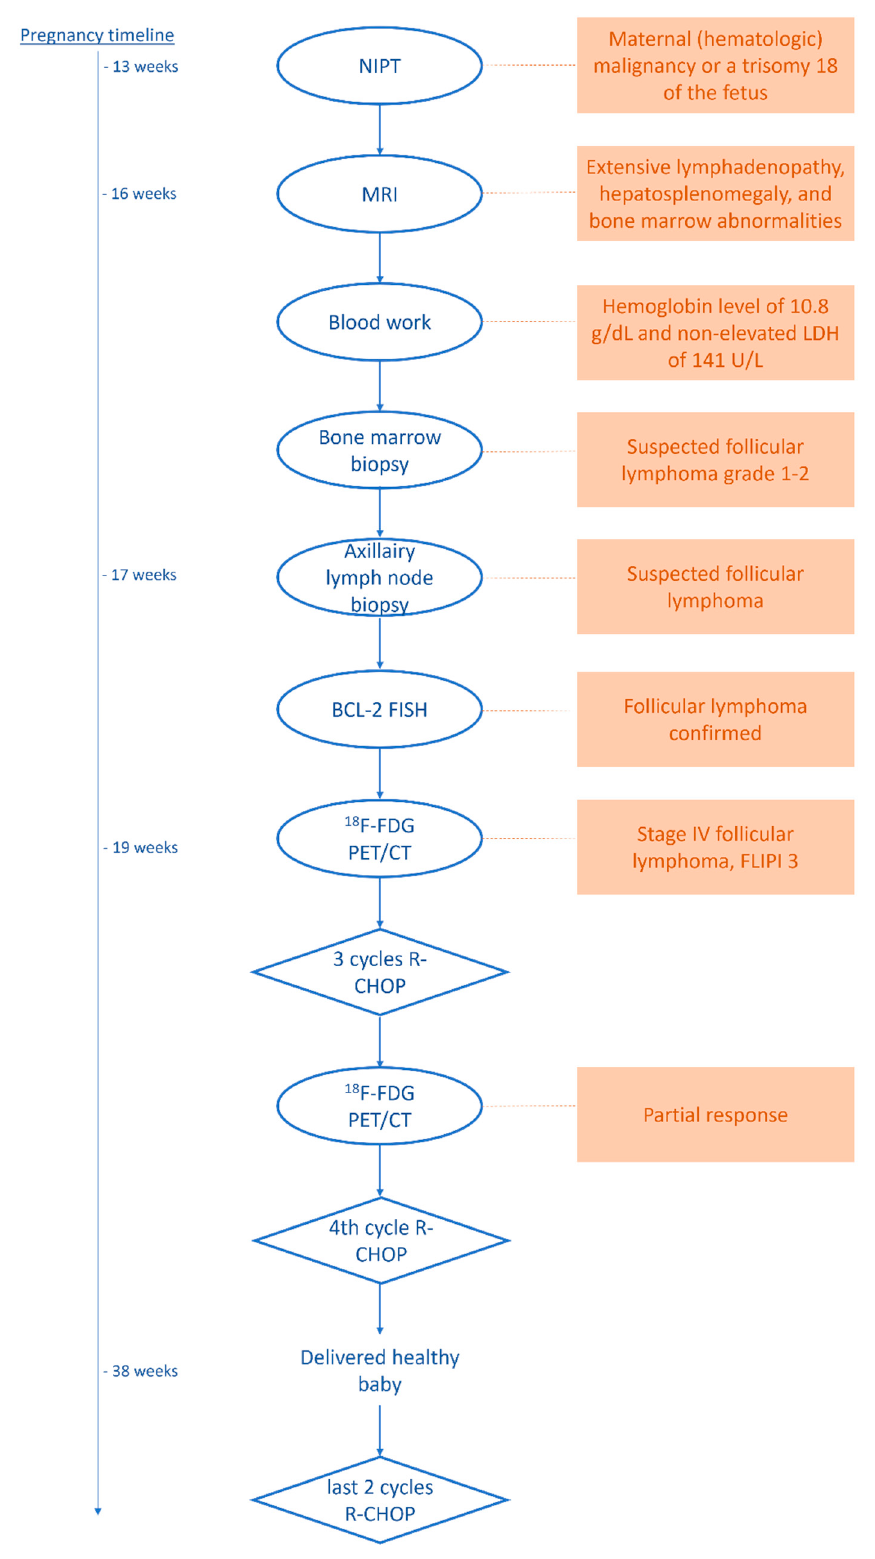
Figure 3. Schematic of the diagnostic procedures, therapy, and